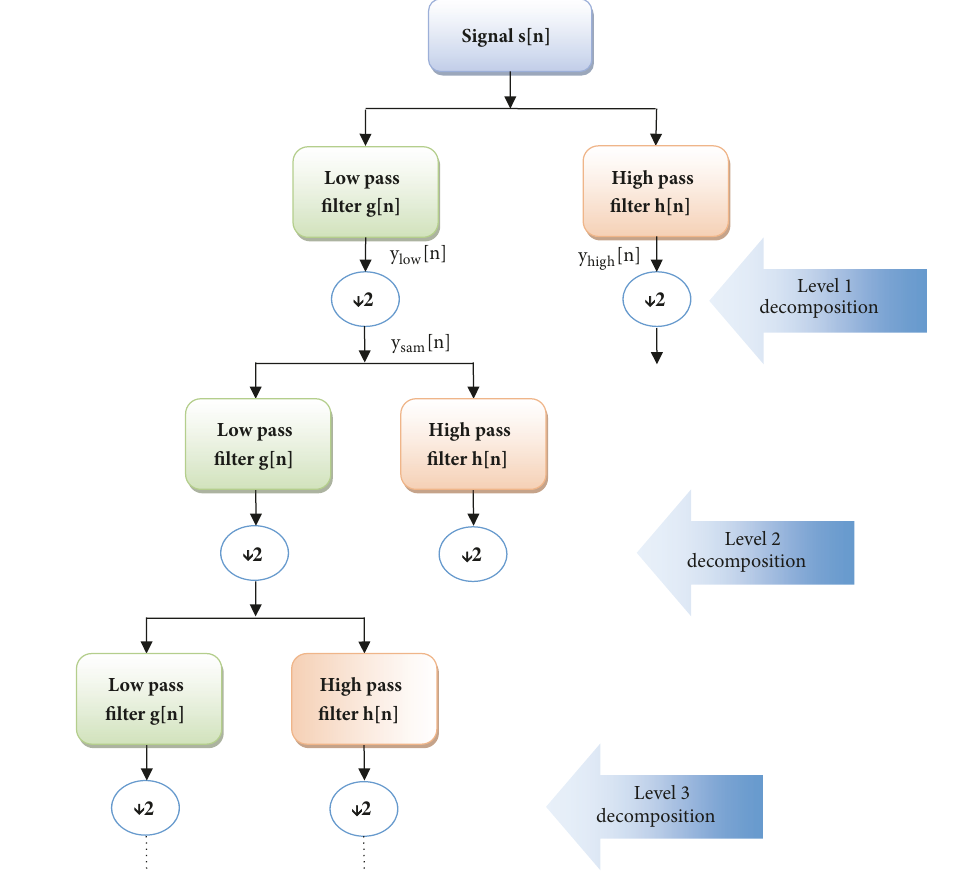
Figure 2: General structure of discrete wavelet